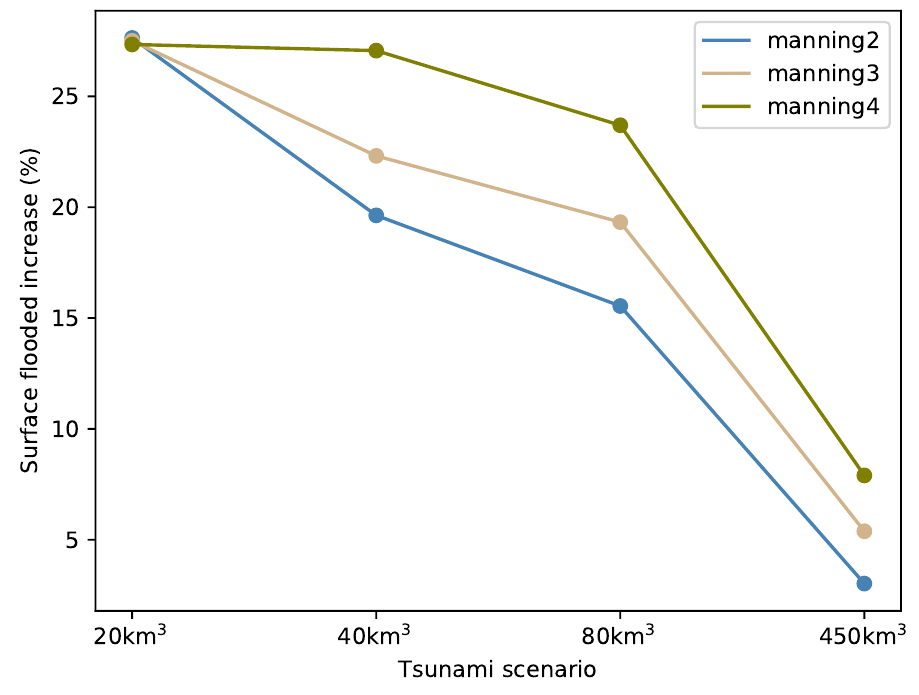
Figure 12. Percentage of change in flooded surface between the current situation and the sea level rise scenario and Manning